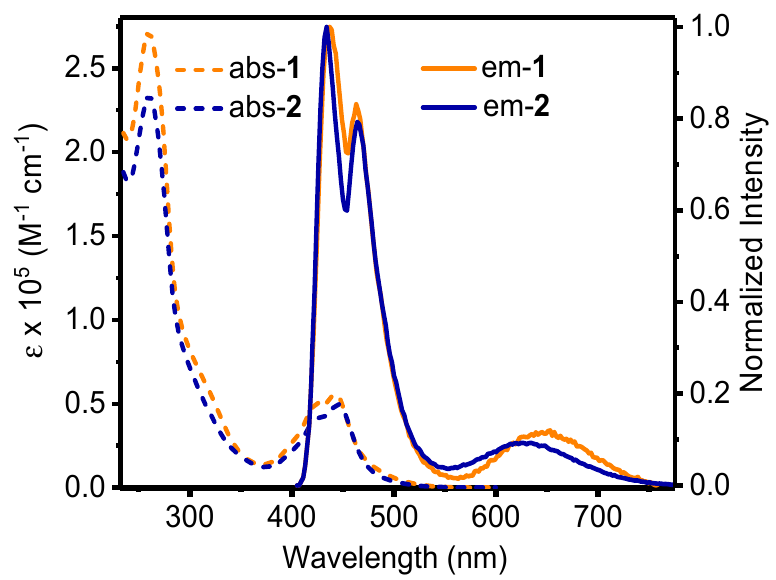
Figure 2. The UV − Vis absorption (dash) and normalized emission (solid) spectra of Au 4 Ag 4 cluster